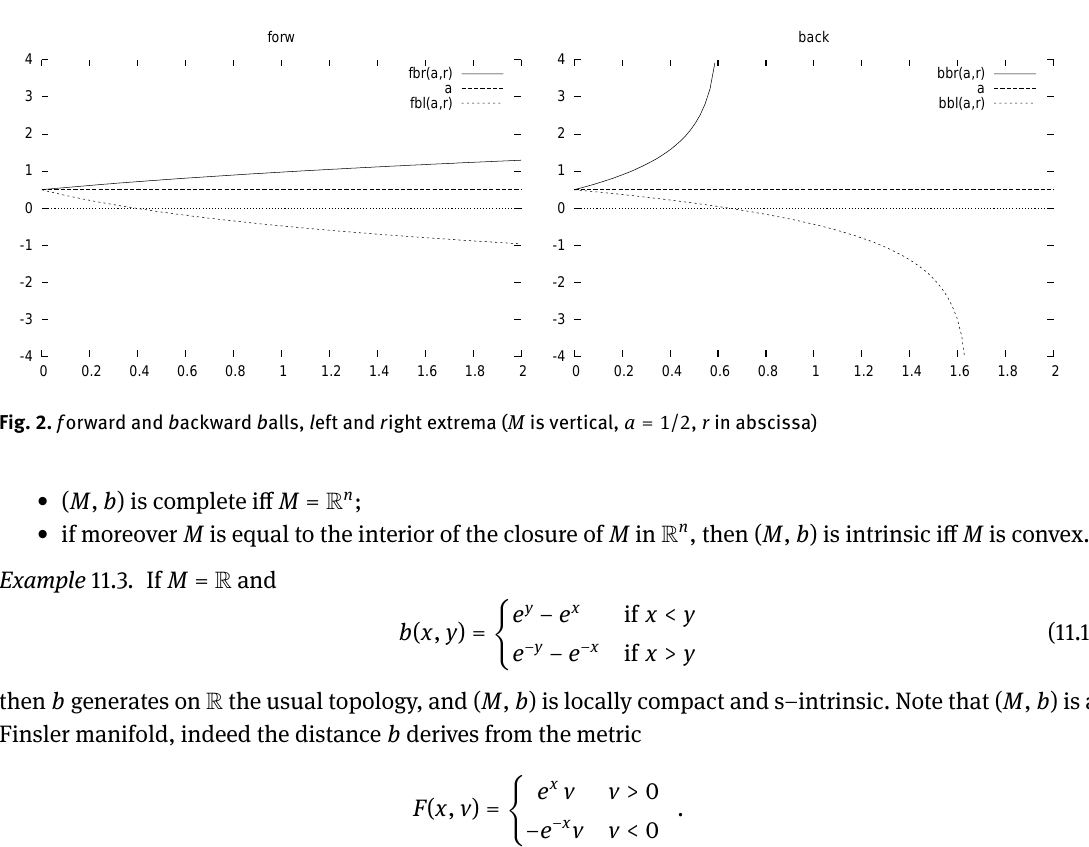
Fig. 1. f orward and b ackward b alls, l eft and r ight extrema ( M is vertical, r = 1/2 , a in abscissa)